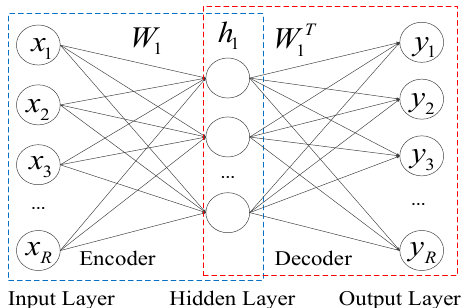
Figure 2. Auto-encoder on the first hidden layer of the DNN.